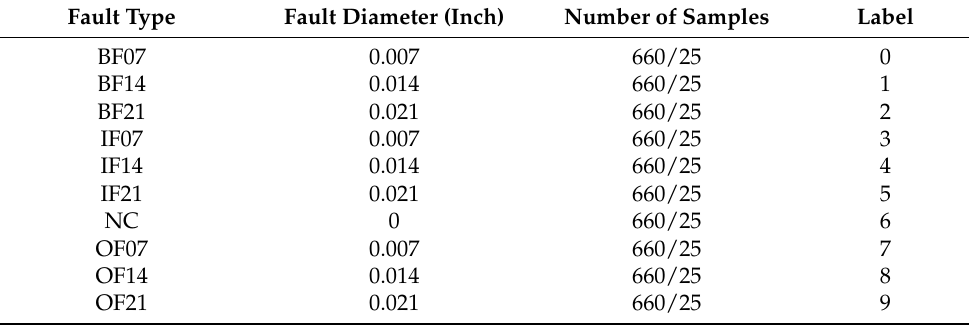
Table 4. Composition of single working condition bearing fault data.